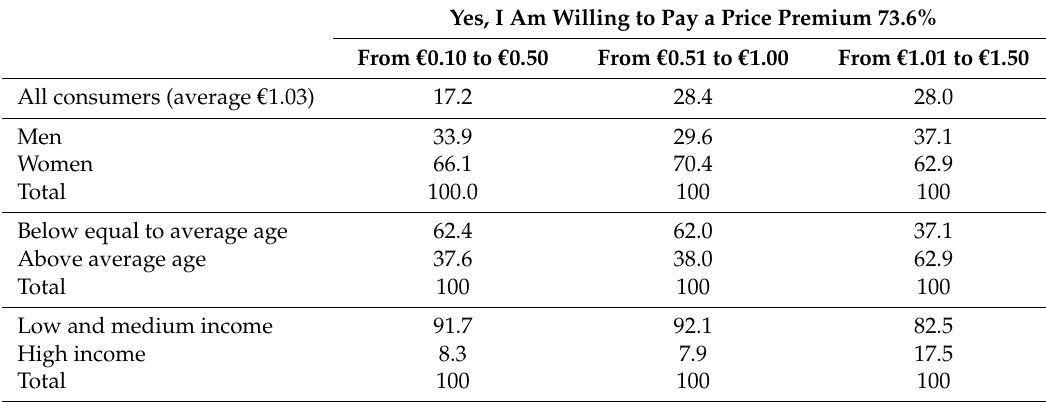
Table 9. Willingness to pay a price premium for coffee with associated health claims